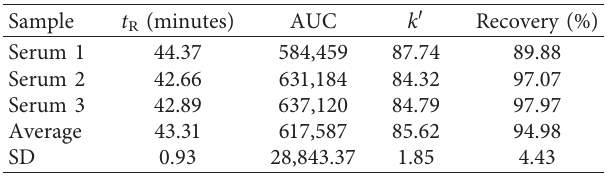
Table 13: Analysis of atenolol in the serum using the monolithic column.